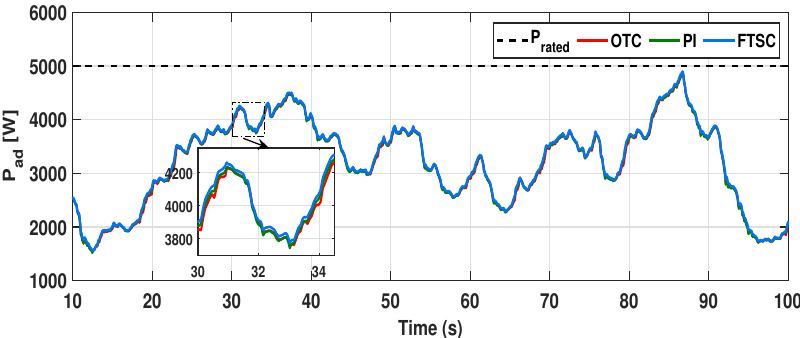
Figure 16. Aerodynamic power captured by the WECS under different control schemes for varying wind profile case-I .